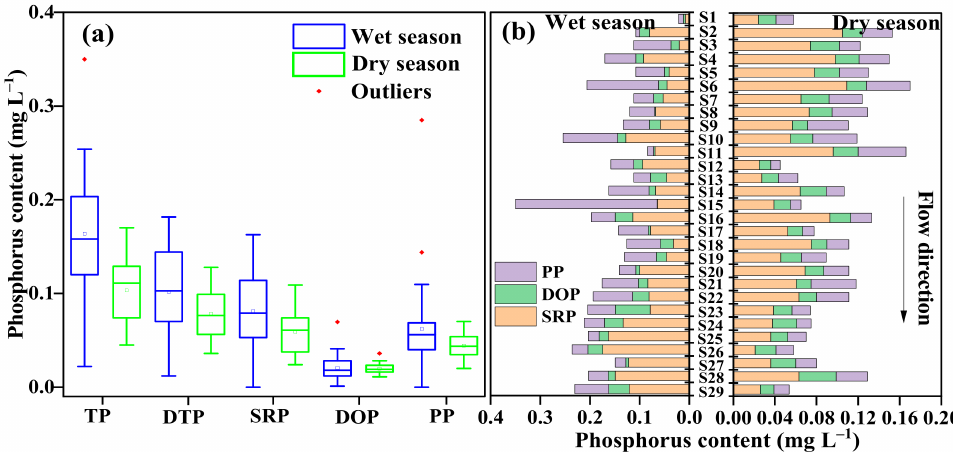
Figure 3. Phosphorus fractions distribution in different seasons ( a ) and sampling sites ( b ) in the water of the Tuojiang River (S1–S29 are defined in Figure